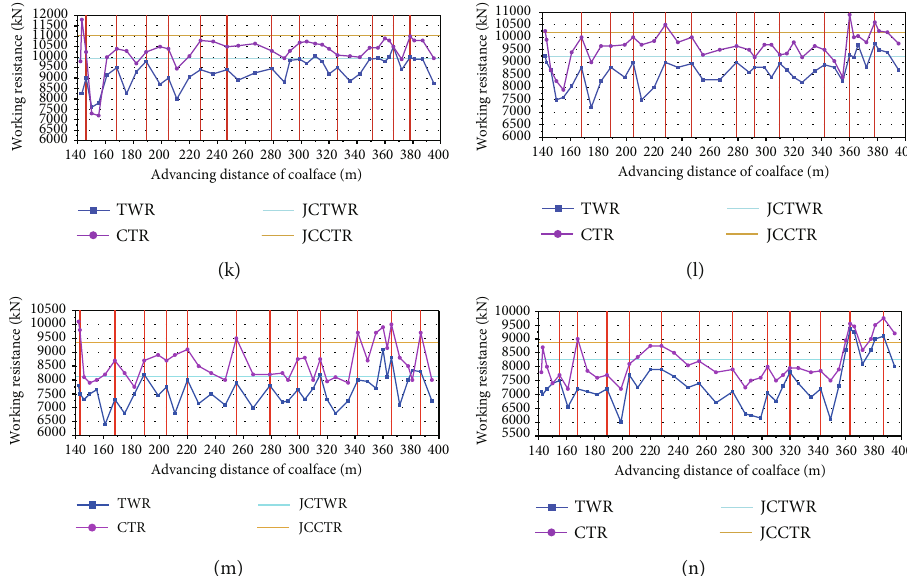
Figure 12: Variation curves of working resistance of some hydraulic supports upon periodic weighting: (a) #4 hydraulic support, (b) #15